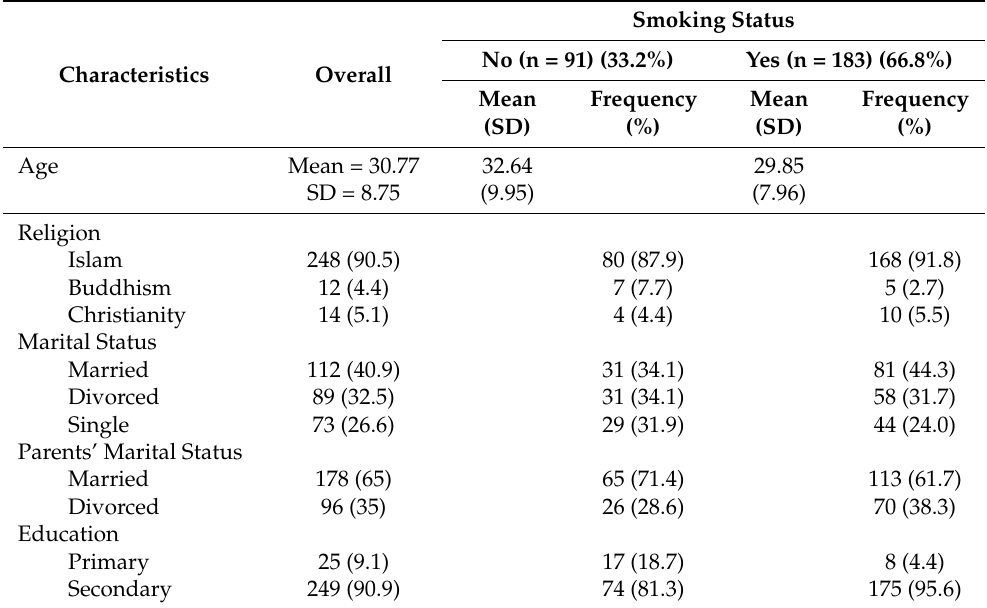
Table 1. Summary of socio-demographic profile among women inmates in Kelantan (n =